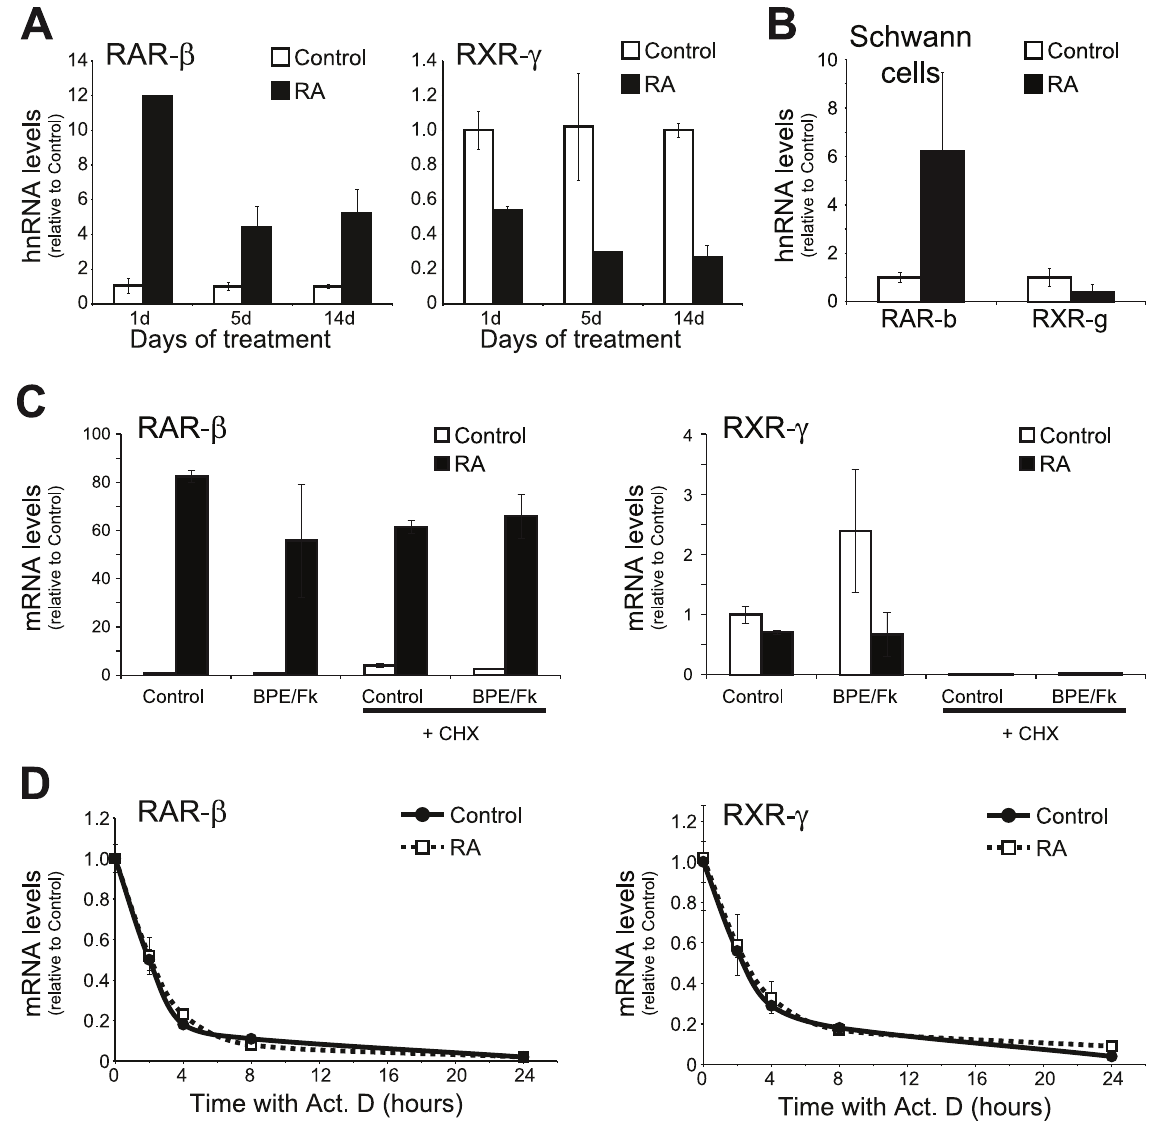
Figure 8. Transcriptional regulation of RAR- b and RXR- c by RA. ( A ) The levels of newly synthesized hnRNA for RAR- b and RXR- c were determined by RT-Q-PCR in myelinating cocultures treated with 1 m M RA for the indicated times. All values are shown as the mean 6 SD relative to their respective controls. ( B ) Newly synthesized RAR- b and RXR- c hnRNA was determined in isolated SCs treated or not with 1 m M RA for 48 hours. All values are shown as the mean 6 SD relative to their respective controls. ( C ) SCs were treated with 1 m M RA in combination or not with the axonal mimickers forskolin and BPE for 24 hours in the presence or absence of 10 m g/ml of the protein synthesis inhibitor cycloheximide (CHX), and RAR- b and RXR- c mRNA levels were determined by Q-RT-PCR. All values are shown as the mean 6 SEM relative to their respective controls in the absence of cycloheximide and retinoic acid. ( D ) Isolated SCs were pretreated or not with 1 m M RA for 24 hours and the stability of RAR- b and RXR- c mRNA was determined by incubating the cells with 10 m g/ml actinomycin D for varying times in the continuous presence or not of the retinoid. All values are shown as the mean 6 SD relative to their respective time zero. RA-treated cells presented RAR- b mRNA levels 59 times higher than control cells, while RXR- c levels were only 40% of those from control